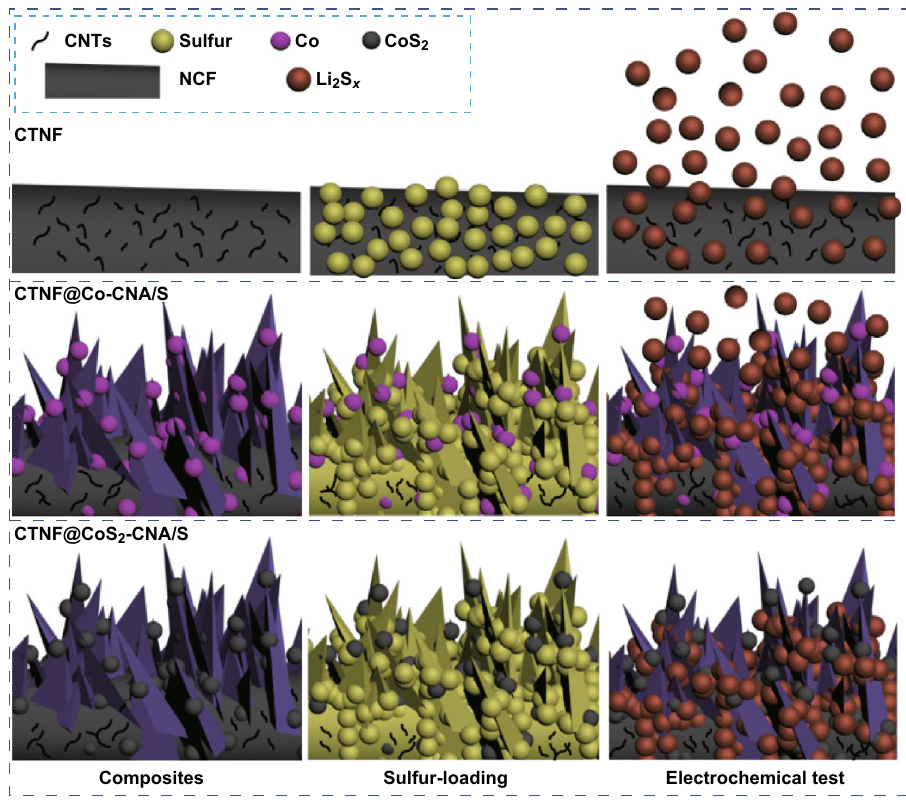
Fig. 6 Schematic illustration of adsorption effects associated with “physical block and chemical absorption” for polysulfides based on CTNF, CTNF@Co–CNA, and